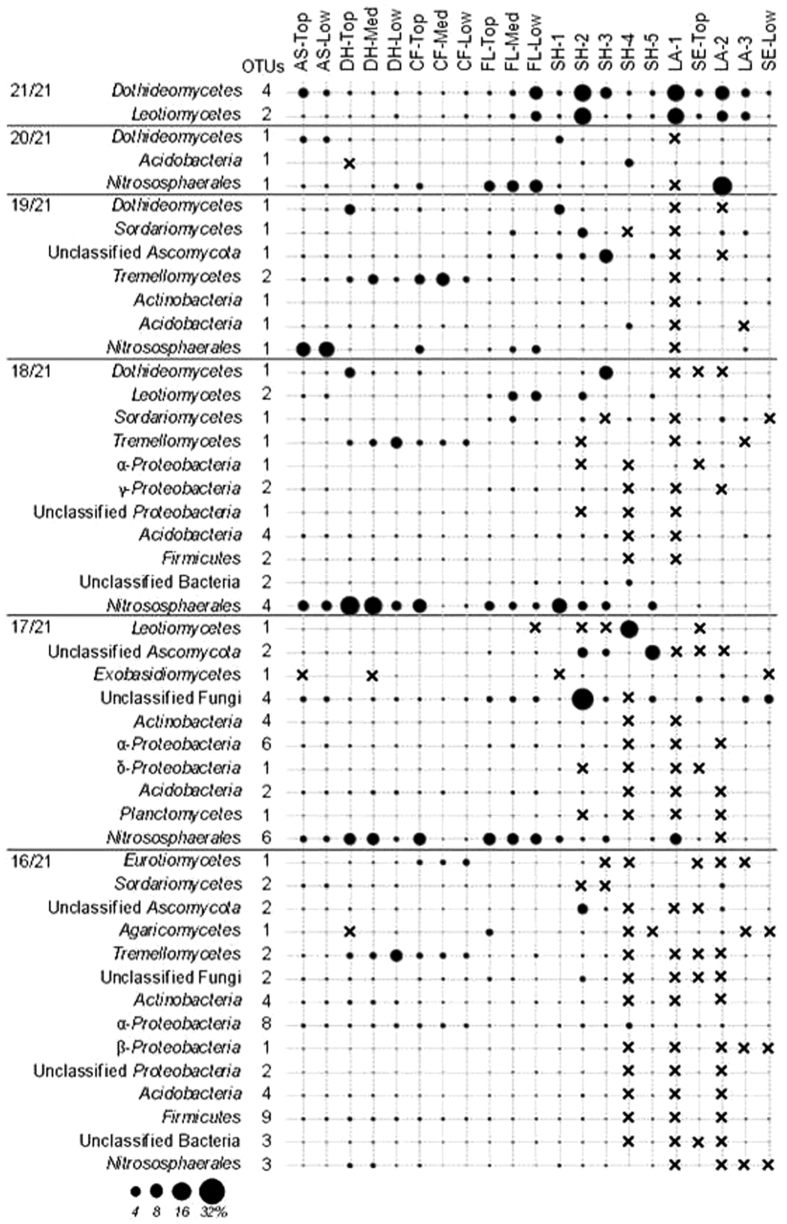
Dot plot of the relative abundance of the habitat generalists detected in all (occurrence 21/21) and almost all the sampling sites (occurrence <21/21).Each sample corresponds to the averages of the biological triplicates. Crosses indicate no detection.